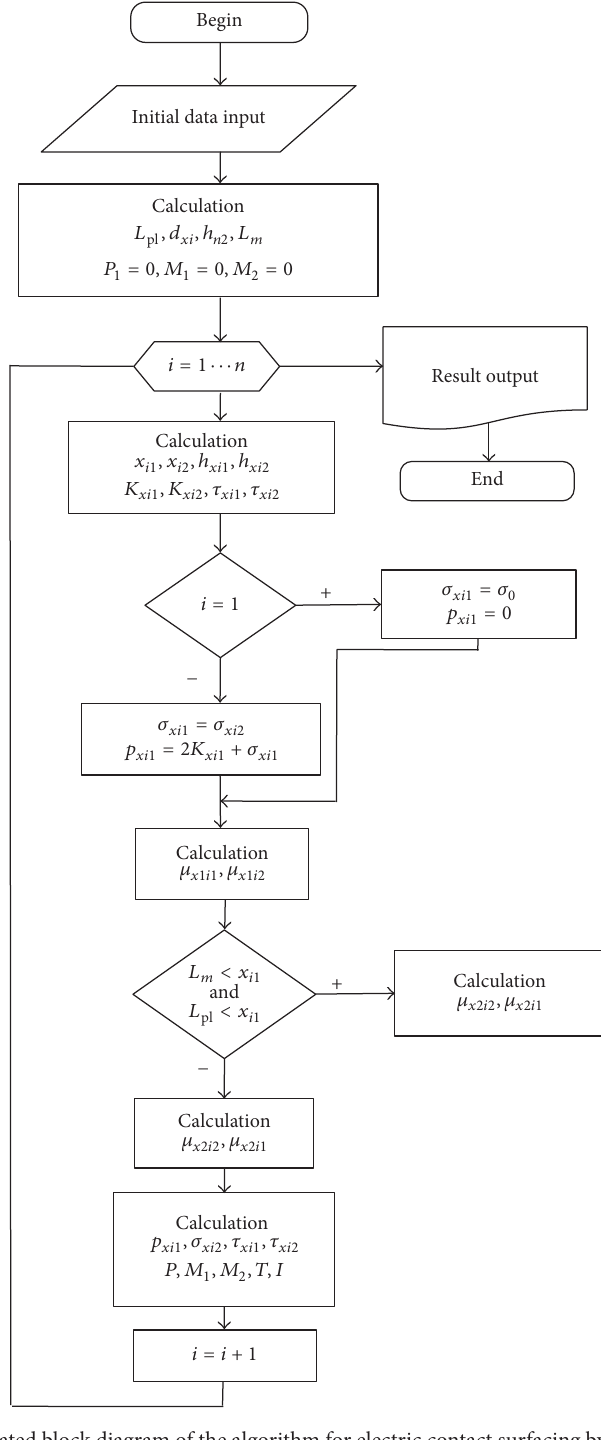
Figure 3: The aggregated block diagram of the algorithm for electric contact surfacing by the compact material.